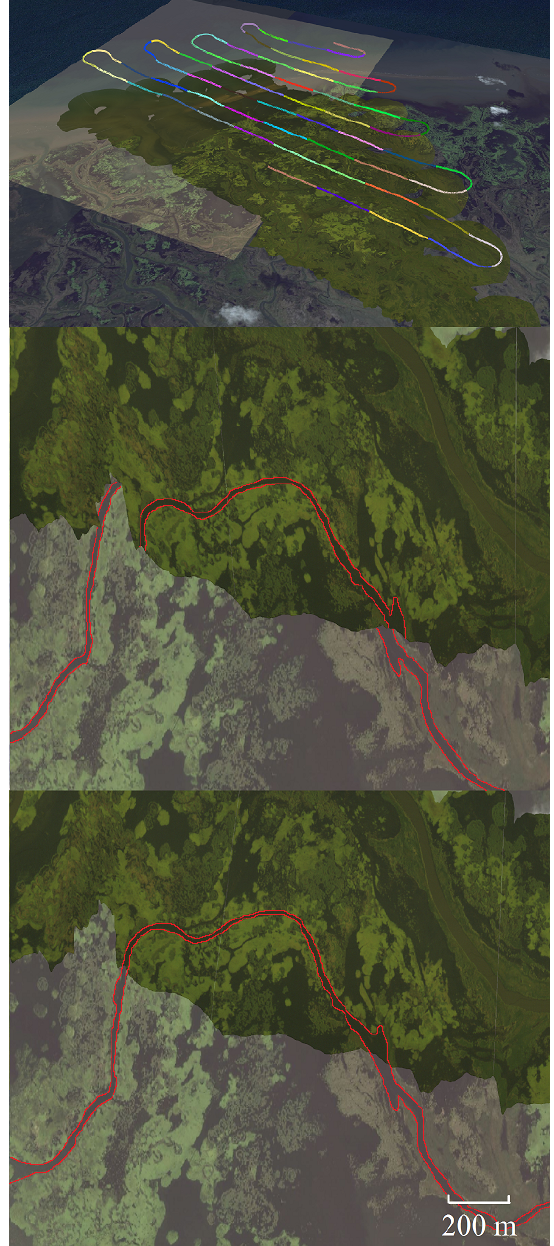
Figure 8. flight path and extract from the projection before and after correction, for flight 3 (Lake Baikal region,